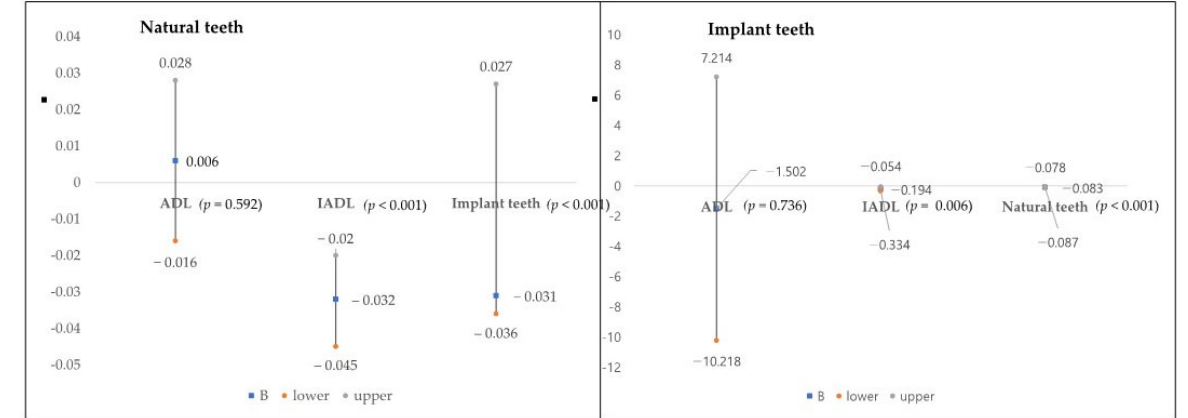
Figure 1. Association between ADL/IADL and natural teeth ( left ) and implant teeth ( right ). B, re- gression coefficient; vertical axis means the number of teeth. ADL, activities of daily living; IADL, instrumental activities of daily living.